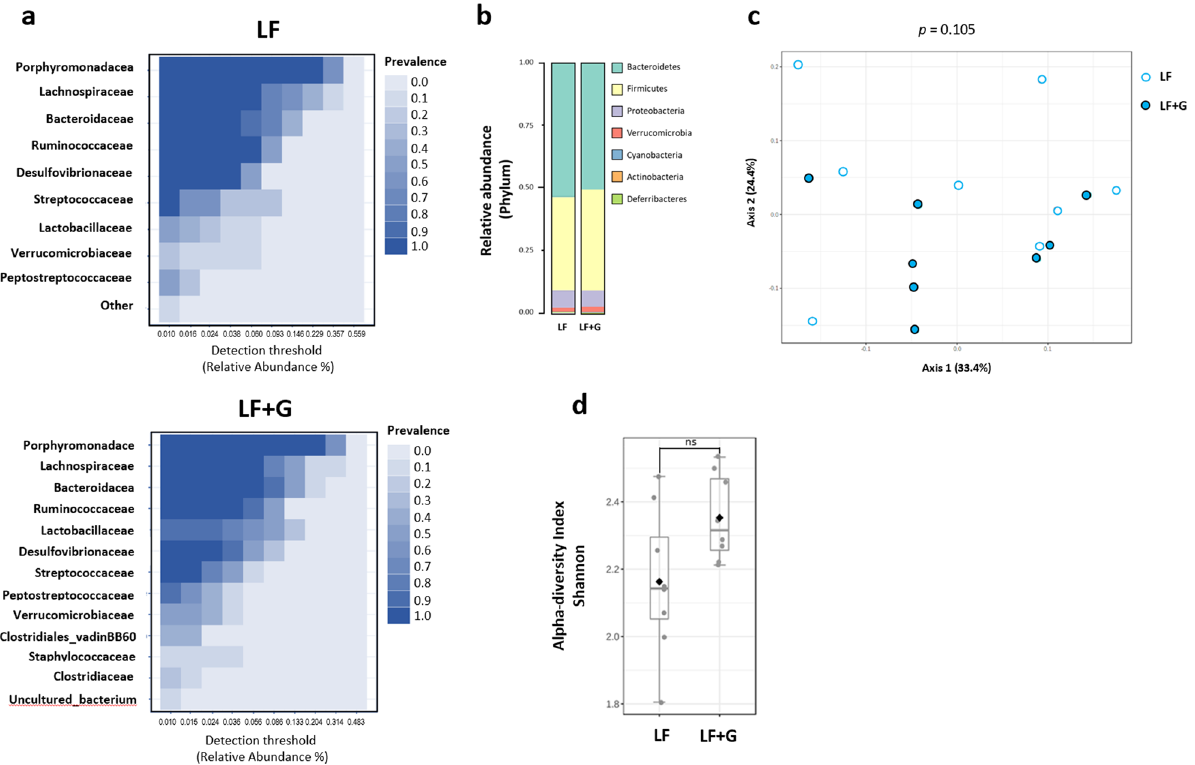
Figure 8. Microbiota composition is not significantly altered upon Giardia infection in mice fed a low-fat diet. The fecal microbiota composition of Giardia -infected LF + G group was investigated at day 7 PI and compared with LF control mice microbiota, respectively. Taxonomic identification of the gut microbiota was assessed via 16S rRNA gene sequencing using Illumina MiSeq platform. The 16S rRNA amplicons were clustered into operational taxonomic units (OTU) with a 97% identity threshold. Data are represented using Total Sum Scaling (proportional abundance of species) to remove sequencing-related technical biases. ( a ) Bacterial taxa at the family level based on their prevalence at a given abundance threshold (core microbiota representation; relative abundance %); prevalence scale ranges from 0.0 (white) to 1.0 (dark blue). ( b ) Bar charts representative of the relative abundance of microbial taxa at the phylum level between LF and LF + G groups. ( c ) The β-diversity between LF (white dots) and LF + G (blue dots) microbial communities was assessed using Bray–Curtis dissimilarity index and visualized through Principal Coordinate Analysis (PCoA) plot. ( d ) The α-diversity was assessed by calculating Shannon diversity index; data are expressed as box plots with min/max whiskers. n = 8 mice per group; LF = low fat control mice; LF + G = low fat infected